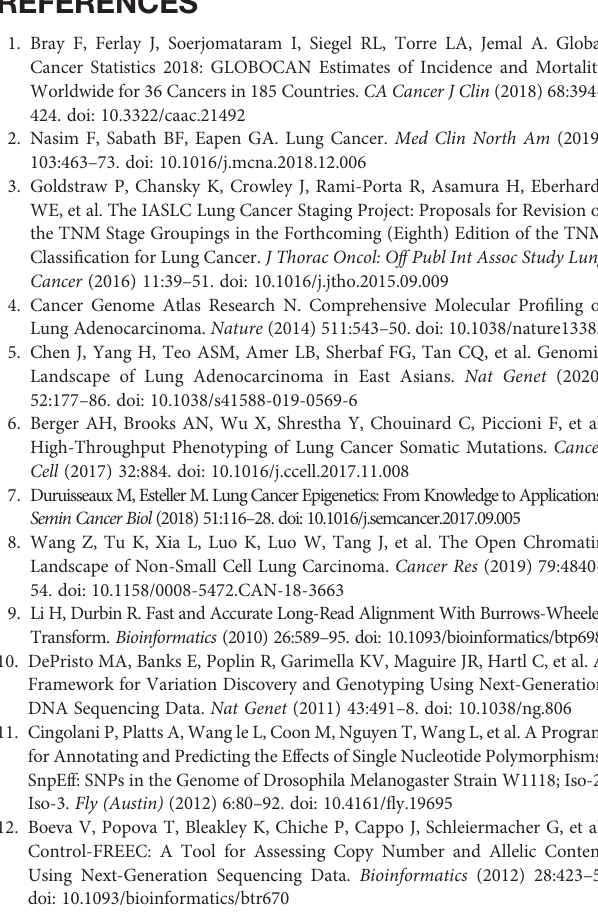
Supplementary Figure S9 | Kaplan – Meier estimates among 17 patients evaluated for expression of ncRNA VLDLR-AS1. Supplementary Figure S10 | Kaplan – Meier estimates among 17 patients evaluated for expression of ncRNA LINC01919. Supplementary Figure S11 | Kaplan – Meier estimates based on TGCA_LUAD database evaluated for expression of ncRNA VLDLR-AS1. Supplementary Figure S12 | Kaplan – Meier estimates based on TGCA_LUAD database evaluated for expression of ncRNA LINC01919. Supplementary Figure S13 | ATAC-seq data analysis. (A) Bar plot shows the number of open chromatin peaks in the 17 LUAD samples. (B) Hierarchical clustering of the Spearman correlation of the ATAC-seq data of all the ES and LS samples. (C) The STRING network analysis of pathways enriched for ES-speci fi c ATAC-seq peak-associated genes. Supplementary Figure S14 | Integrative analysis of ATAC-seq peaks with copy number variation. (A) Boxplot shows the relationship between copy number (normal, gain and loss) and the signal intensity of ATAC-seq peak that located in corresponding regions. (B) Scatterplot represents the correlation between the copy number of CNV gain regions and the signal intensity of ATAC-seq peaks. Supplementary Figure S15 | KEGG pathway enrichment analysis. ES-speci fi c ATAC-seq peak-associated genes (A) and LS-speci fi c ATAC-seq peak-associated genes (B)